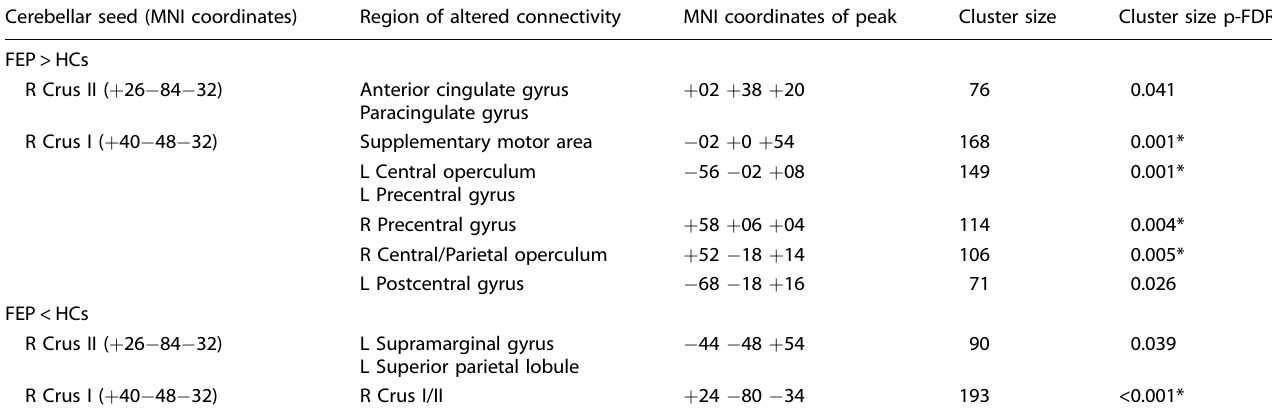
Table 2. Brain regions demonstrating signi fi cant cerebellar connectivity differences in patients with fi rst-episode psychosis (FEP) versus healthy controls (HCs).